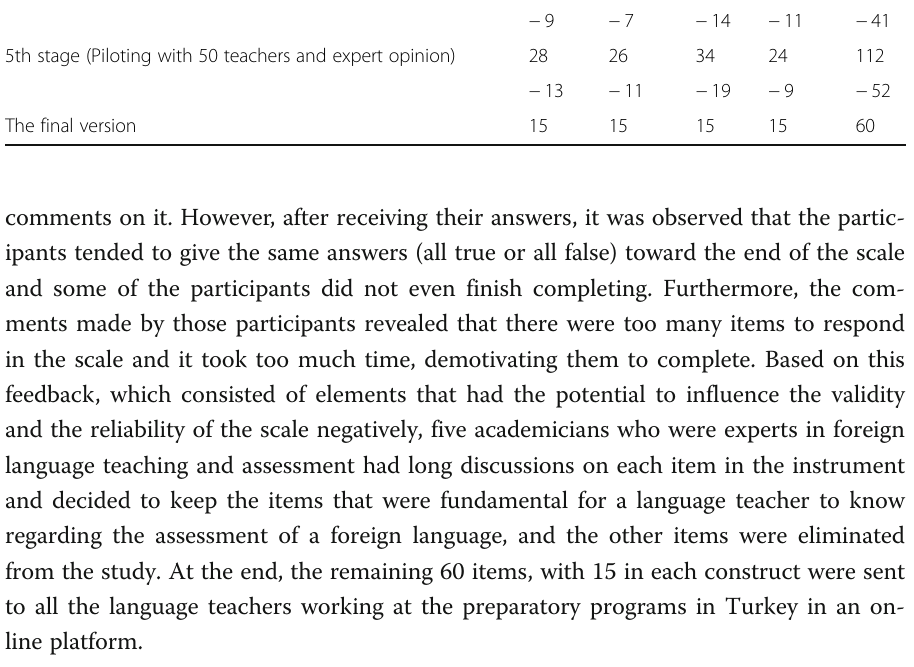
Reading Listening Writing Speaking In